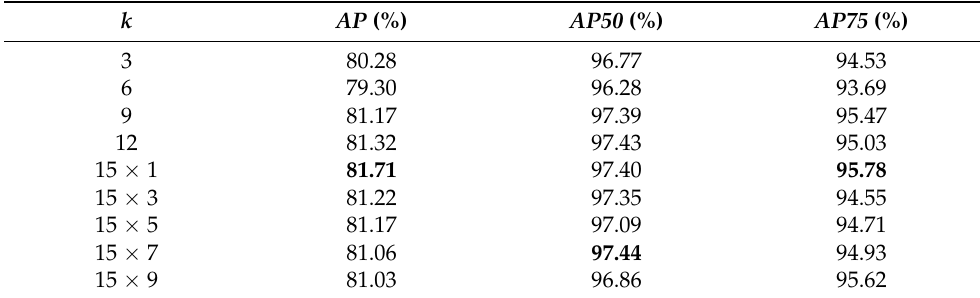
Table 4. Analysis of different values of k on the UED dataset.